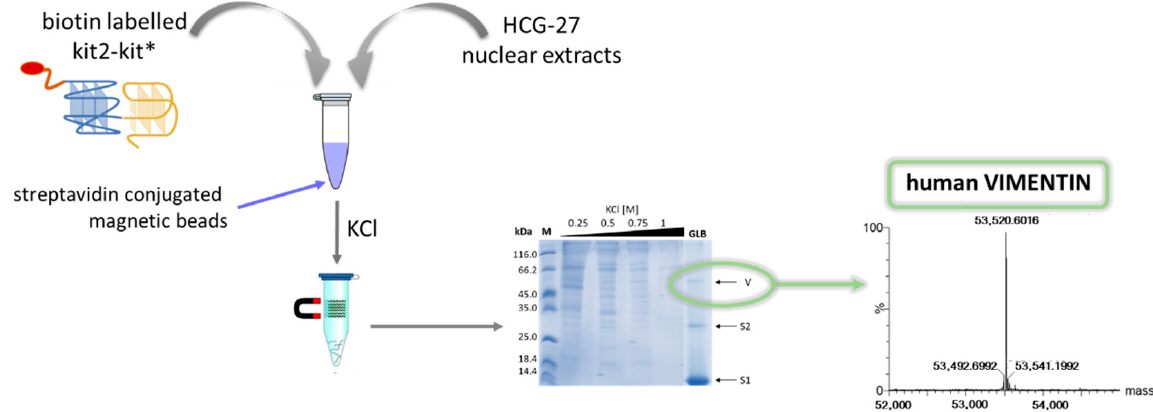
Figure 6. Outline of a pull-down approach leading to the discovery of vimentin as a G4 repeat selective binder (adapted from [68]).